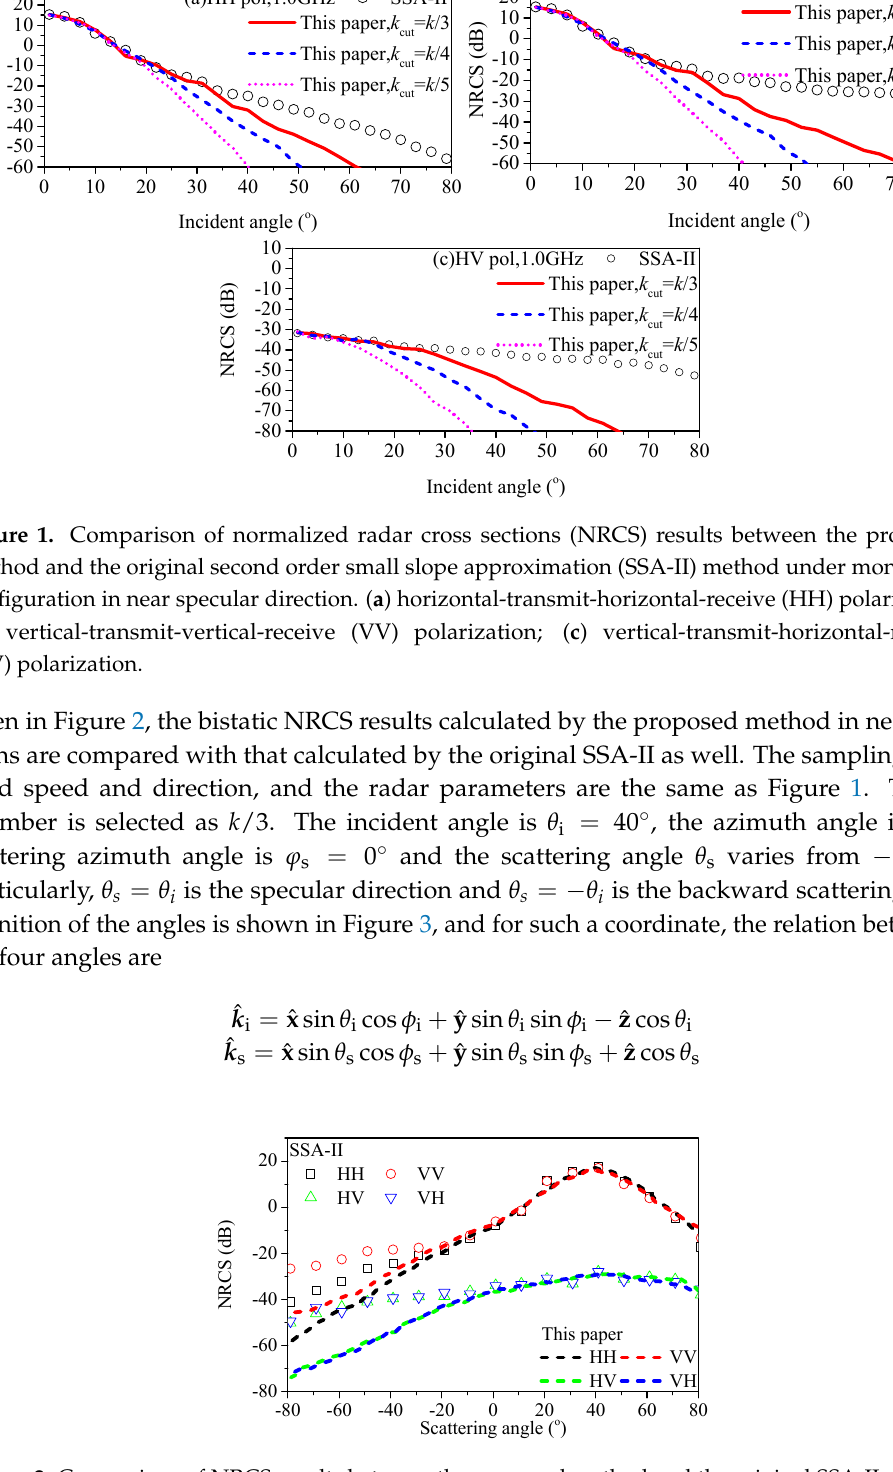
Figure 2. Comparison of NRCS results between the proposed method and the original SSA-II method under bistatic configuration in the near specular regime.